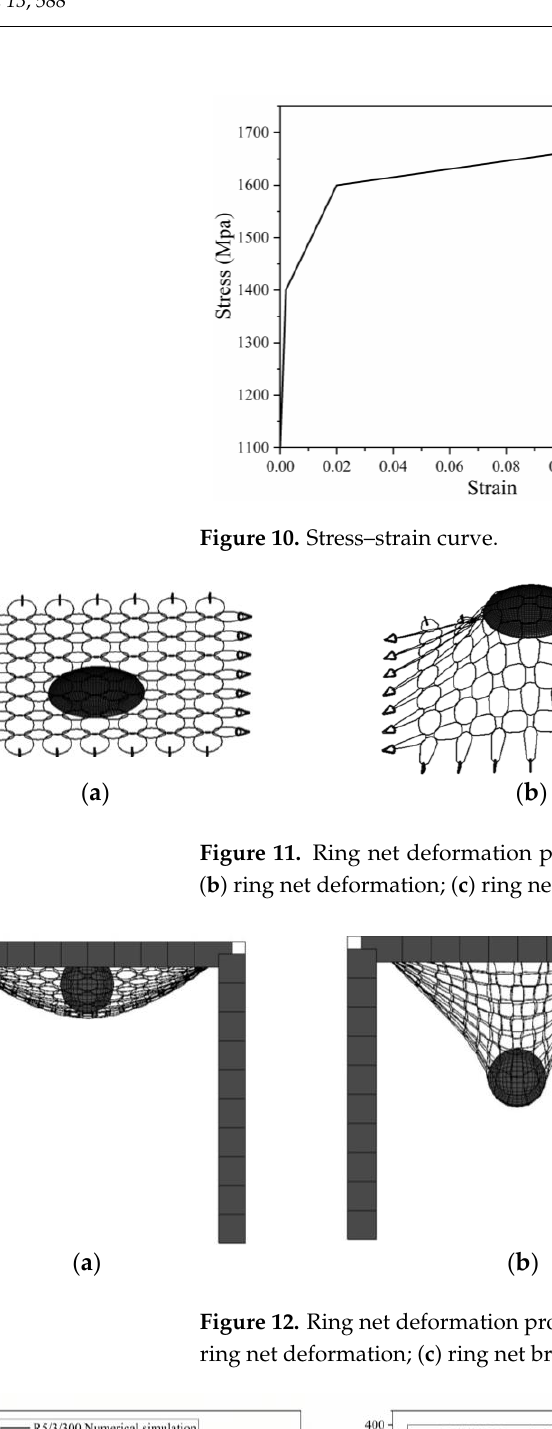
Figure 12. Ring net deformation process in the dynamic impact test: ( a ) ring net relaxation state; ( b ) ring net deformation; ( c ) ring net breakage.